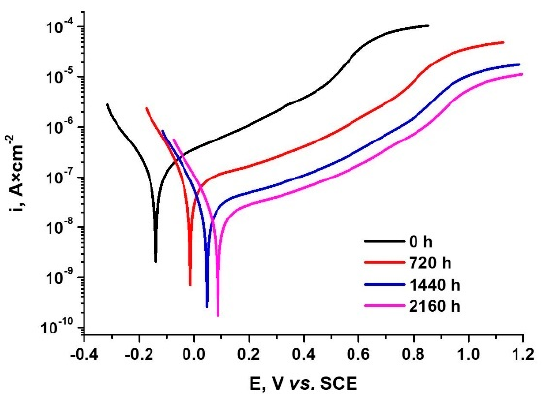
Figure 9. Potentiodynamic plots for CrN x -coated 310 H SS sample before and after exposure for different periods in supercritical water (550 °C, 25 MPa) at a scan rate of 0.5 mV × s − 1 .